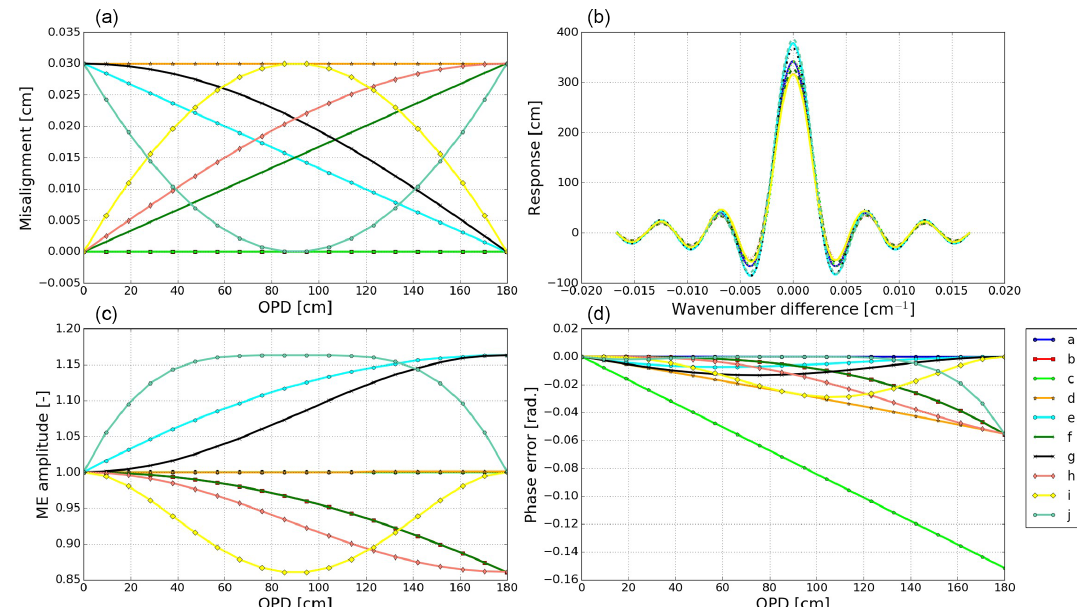
Figure 1. Simulated ILS degradation with respect to different types of misalignment. The results are derived from ALIGN60. Panel (a) demonstrates different types of misalignment (a to j) used in the simulation, panel (b) shows the resulting ILS, panel (c) shows the resulting ME amplitude, and panel (d) shows the resulting PE. Descriptions of the misalignments a to j are listed in Table 1.